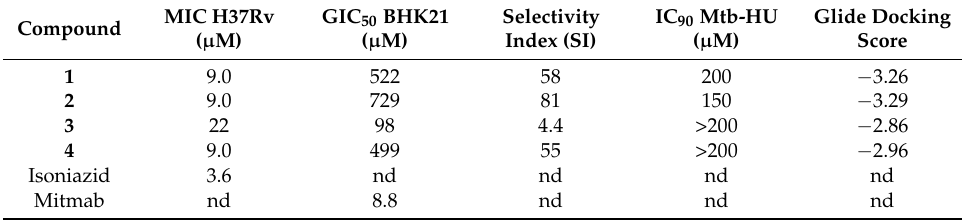
Table 1. Antituberculosis activity against Mycobacterium tuberculosis H37Rv, cytotoxicity of BHK21 mammalian cell line and Mtb-HU protein inhibition by the diarylethenes 1 – 4 .